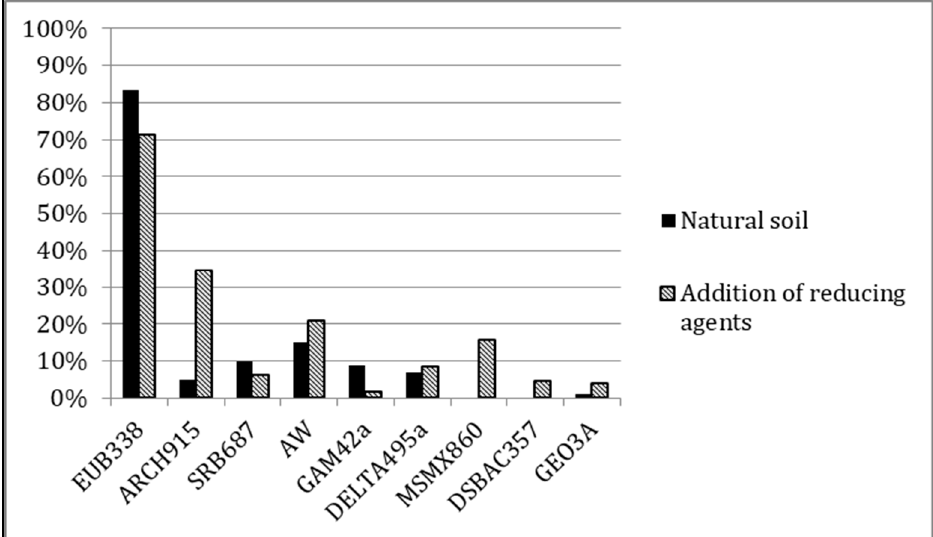
Figure 5. FISH microbial analysis results on natural soil and after the addition of the reducing agents (Molasses, EVO and FeSO 4